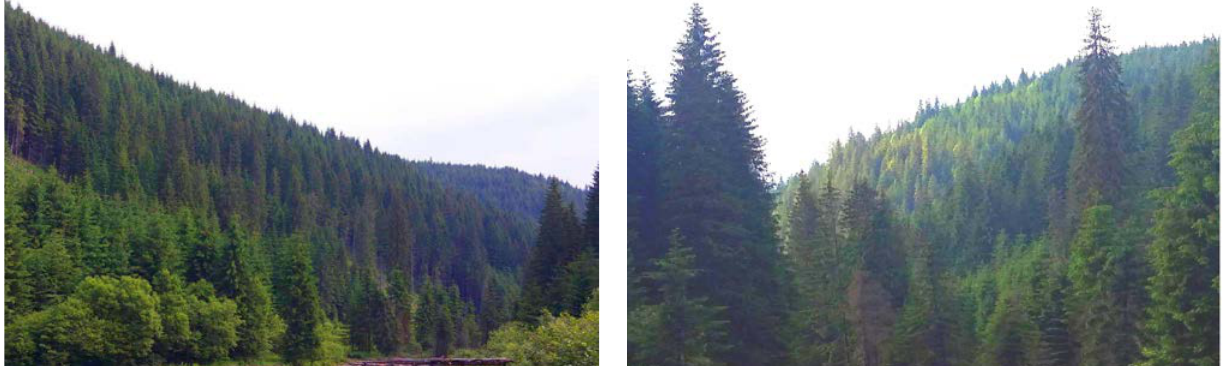
Fig. 6. Landscape aspects from the study unit showing slope exposition (N-E left and S-W right) and altitude within the local environmental